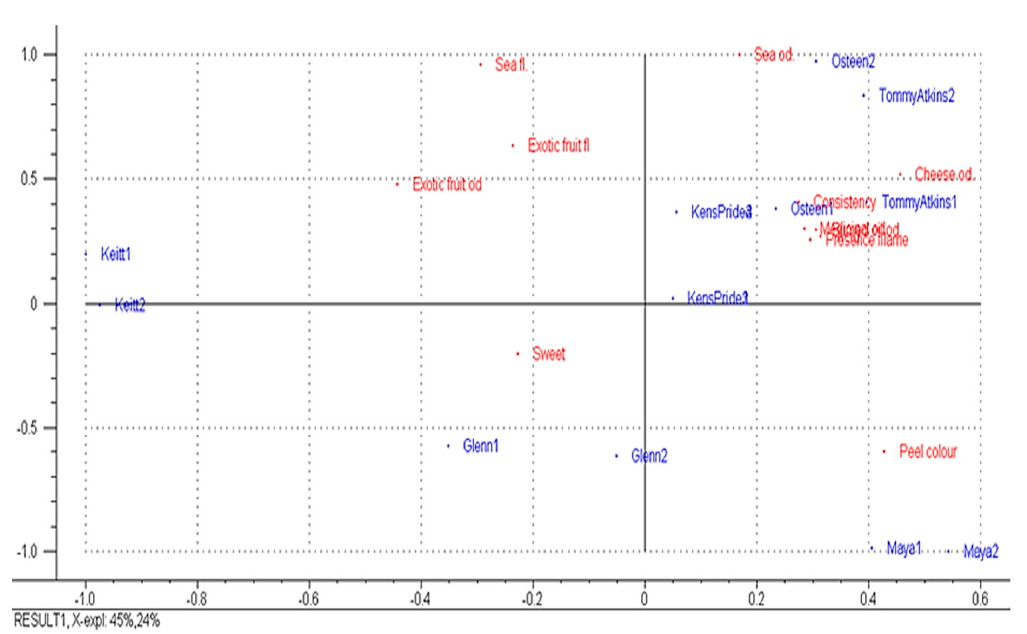
10 of 14 Figure 1. Sensory profiles of the six observed mango cultivars as evaluated by a trained panel. Data are mean values ± SD ( n = 30). In fact, panellists rated mangoes of cv. Keitt to be the worst for colour. Moreover, this cultivar presented the highest values for exotic fruit odour and flavour, as well as for sweetness at par with